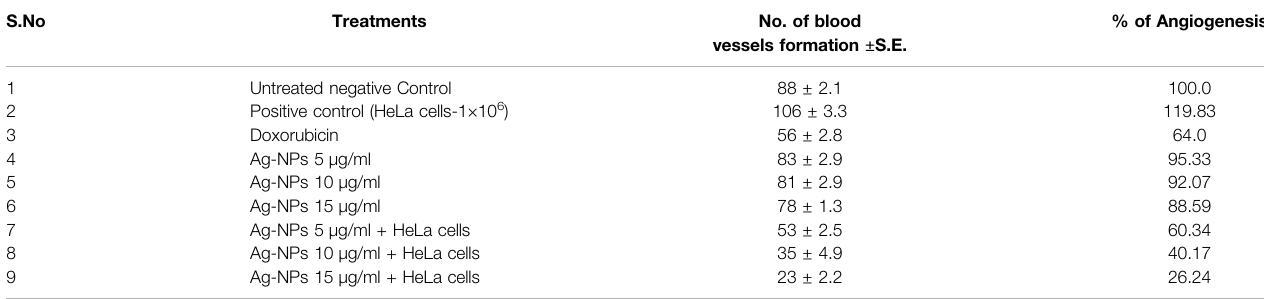
TABLE 1 | Percentage of angiogenesis and reduction in blood vessel formation assessed using CAM